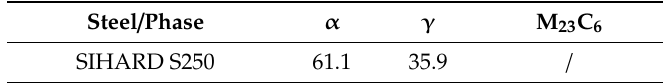
Figure 3. ( a ) Microstructure of steel after compression test, and ( b ) corresponding X-ray diffraction spectrum. Table 3. Phase fractions in SIHARD S250 steel after applied compression load.